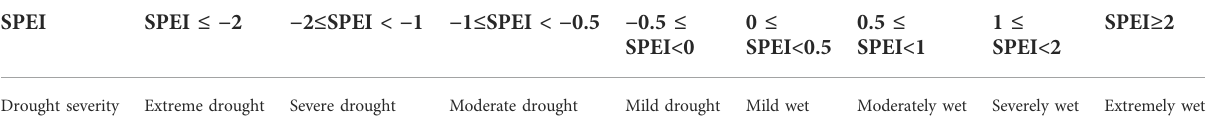
TABLE 1 Wet and dry classi fi cation based on the standardized precipitation evapotranspiration index